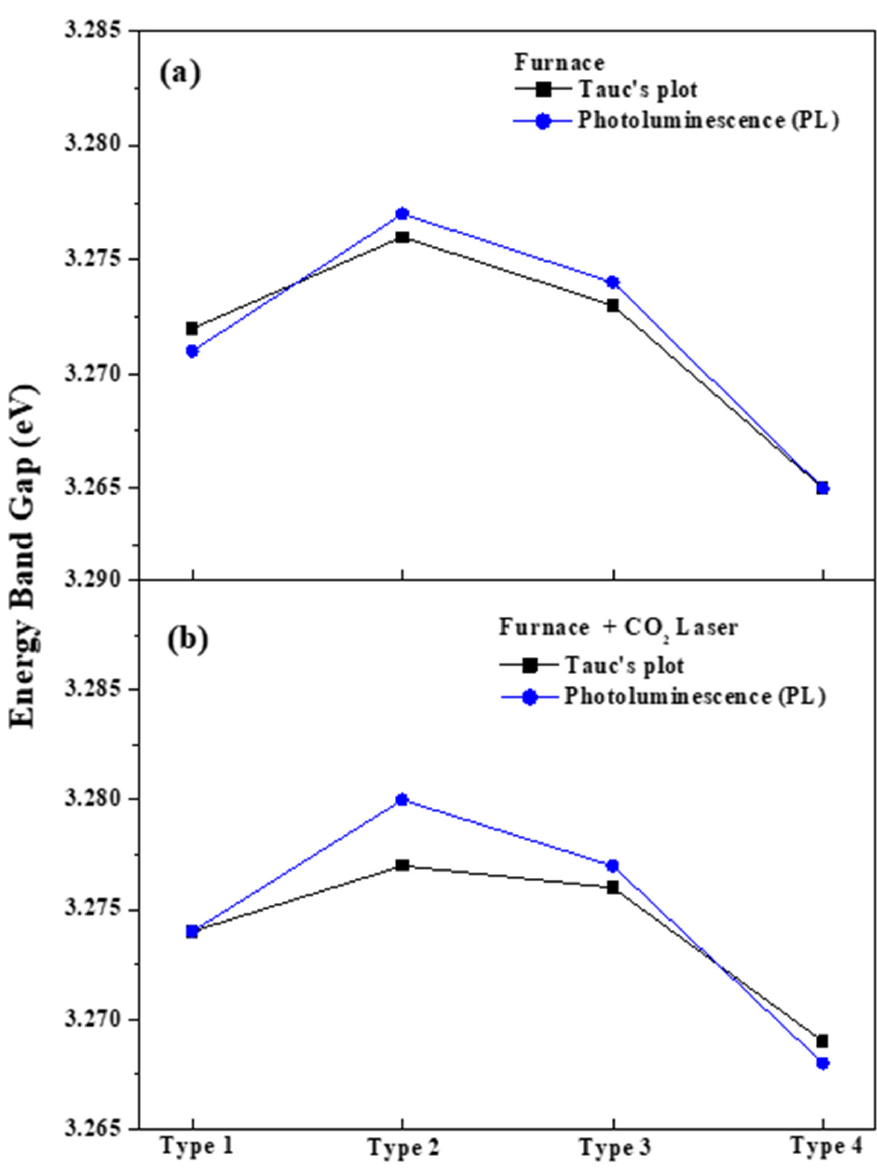
Figure 9. Energy band gap of 4 types of (In, Ga) co-doped multilayered thin films extracted from Tauc’s plot and measured by PL spectra.; ( a ) annealing effect, ( b ) post-annealing effect .